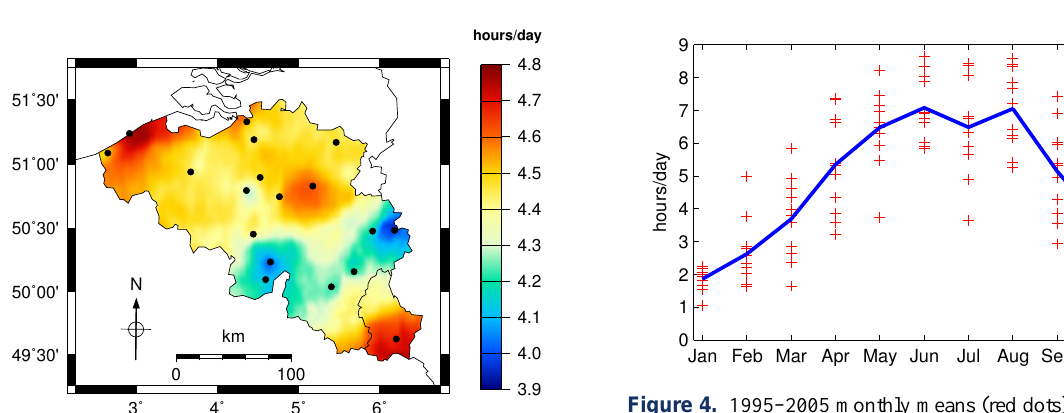
Figure 4. 1995–2005 monthly means (red dots) and monthly nor- mals (blue line) of the daily sunshine duration spatially averaged over Belgium and